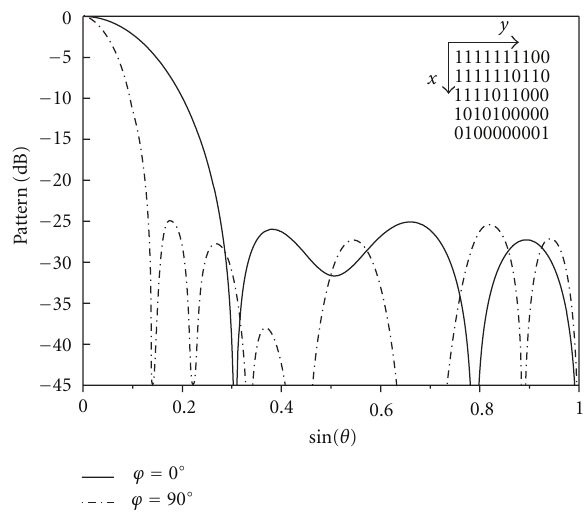
Figure 1: Radiation patterns of the optimized 20 × 10-element pla- nar array with the fitness function as